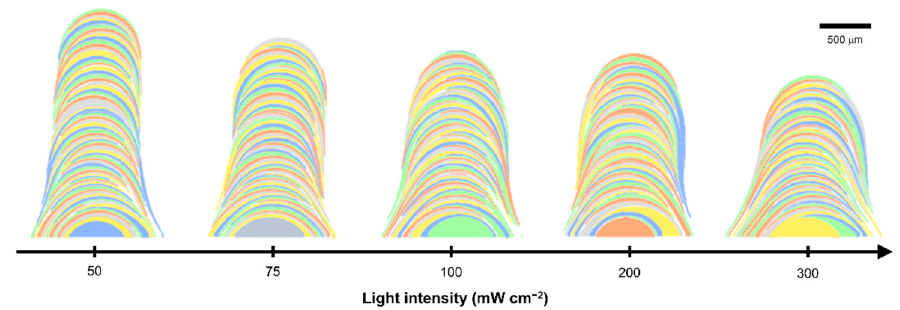
Figure 4. Final structures formed by successive deposition of single layers at different light intensi ‐ ties.